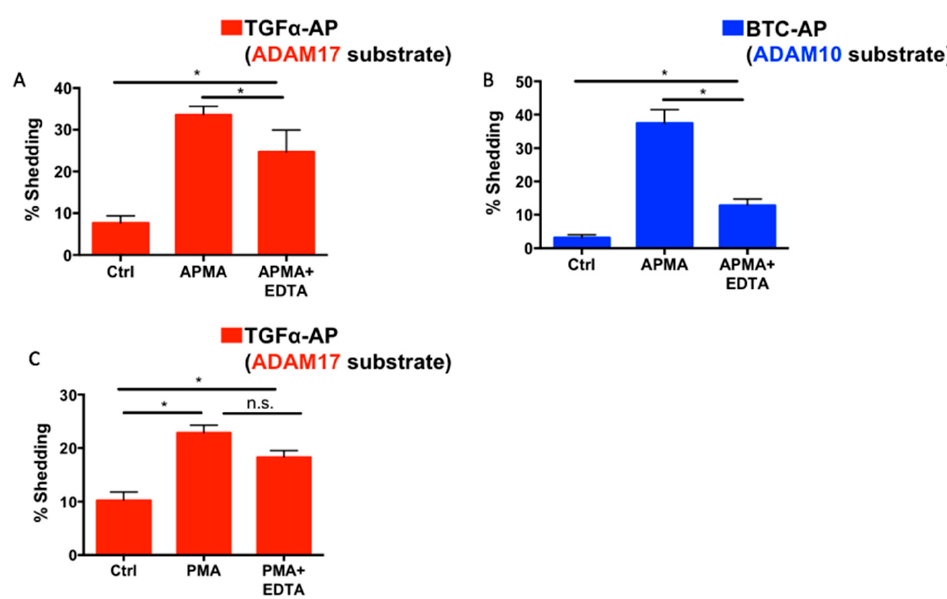
Figure 6. ADAM10 activity is more strongly inhibited by EDTA than ADAM17. ( A,B ) After 6 h of starvation in Opti-MEM, WT mEFs were treated with 4-amino-phenylmercuric acetate (APMA, 200 µM) in the presence or absence of 5 mM of EDTA for 30 min. APMA treatment induced the shedding of the ADAM17 substrate TGF α -AP (A) and the ADAM10 substrate BTC-AP (B). APMA-induced BTC-AP shedding, which depends on ADAM10, was more strongly reduced by treatment with 5 mM of EDTA than APMA-induced TGF α -AP shedding, which depends on ADAM17. In addition, PMA-induced TGF α -AP shedding, which depends on ADAM17, was not significantly reduced in the presence of EDTA ( C ). Data are shown as mean ± SEM for n ≥ 3 independent experiments. * indicates p < 0.05 and n.s. indicates no statistically significant difference using one-way ANOVA followed by Tukey’s multiple comparisons test.